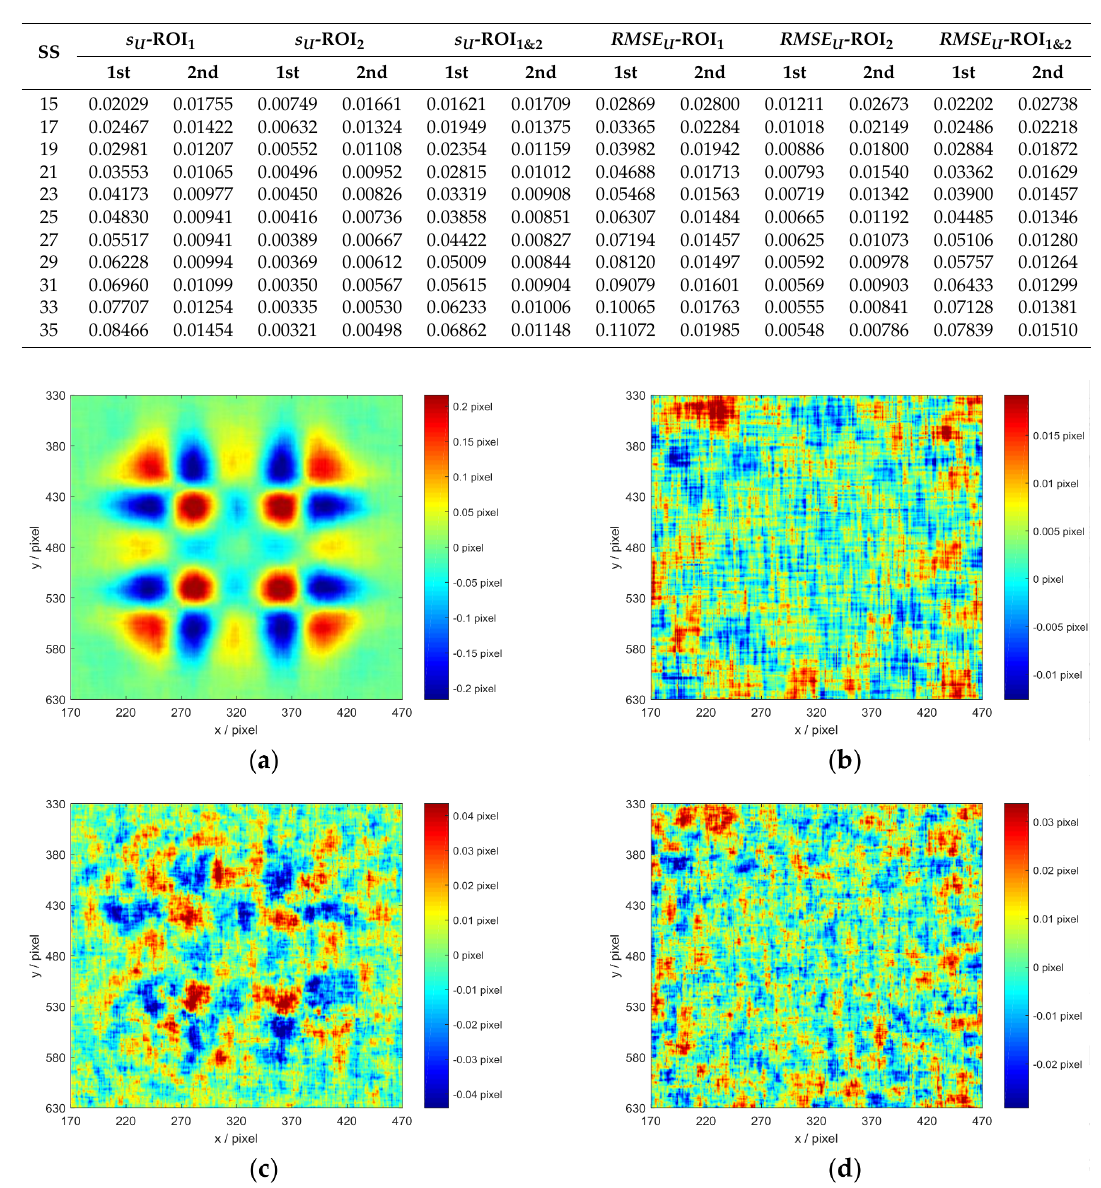
Table 1. Comparison of measured displacement errors with different subset sizes (SS) by IC-GN 1 (1st) and IC-GN 2 (2nd) of ROI 1 , ROI 2 , and ROI 1&2 (unit: pixel).